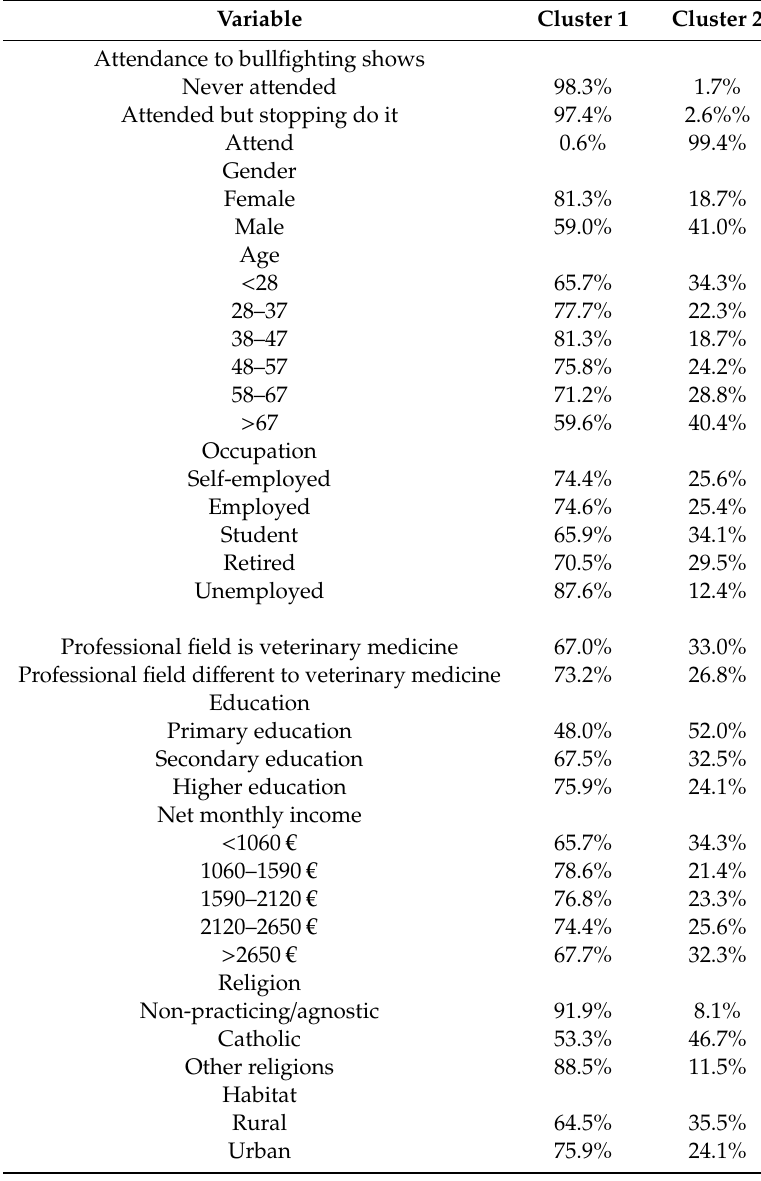
Table 6. Within cluster composition of demographic profiles in Portugal within the clusters obtained by a two-step cluster